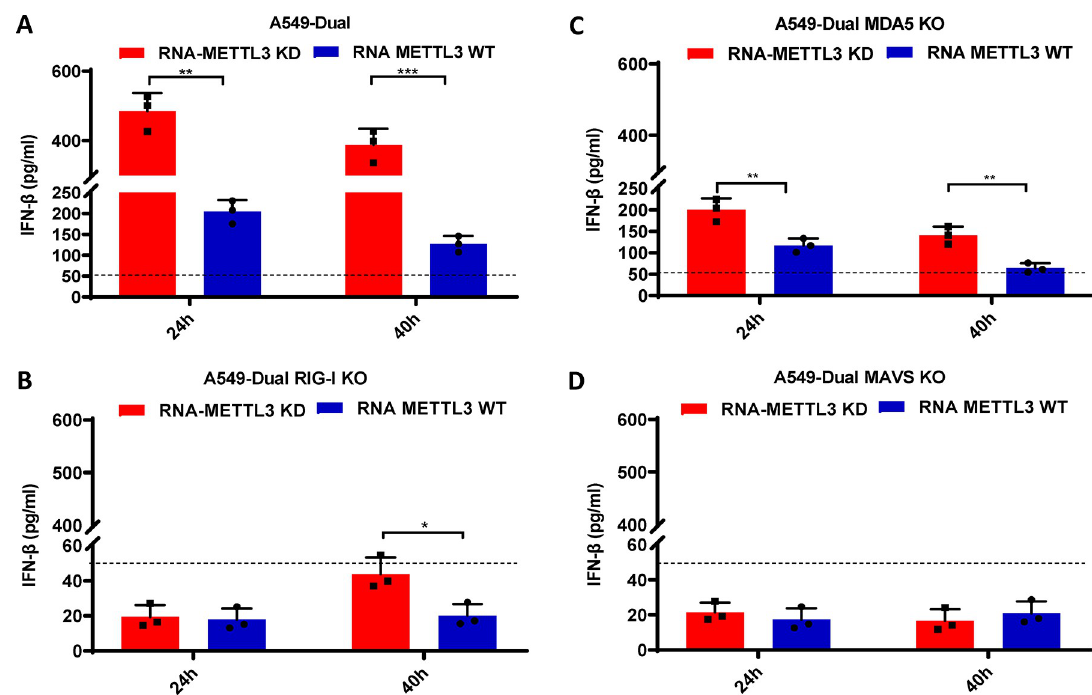
Fig 2. RIG-I is the main RNA sensor that recognizes m 6 A-deficient RSV virion RNA. Confluent wild-type (A), RIG-I -knockout (B), MDA5 -knockout (C), or MAVS -knockout (D) A549 Dual cells were transfected with same amount (2 × 10 7 RNA copies) of RSV virion RNAs from either METTL3 KD cells or METTL3 WT cells. Cell culture supernatants were harvested at 24 and 40 h after inoculation, IFN- β in the supernatant at indicated time points was measured by commercial ELISA kit. Error bars represent SD from n = 3 independent experiments. � P < 0.5, �� P < 0.01, ��� P < 0.001, ���� P <